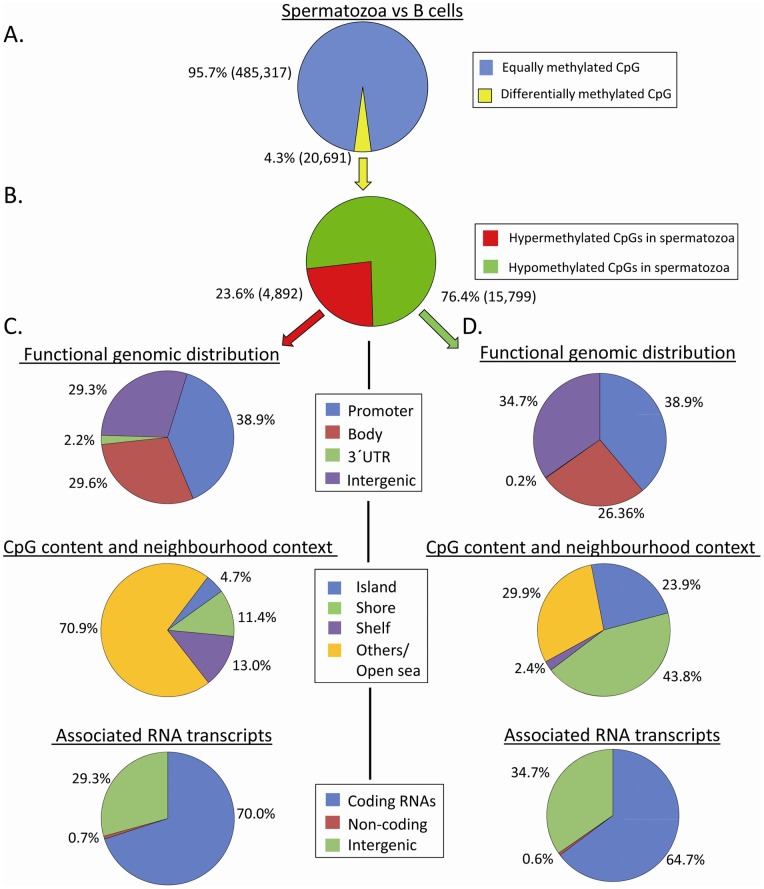
Spermatozoa versus B cell: a 450K DNA methylation
portrait.(A) Graph showing percentages of equally and differentially
methylated CpG sites in swim-up sperm samples compared to B cells.
(B) Graph showing percentages of hypermethylation and
hypomethylation in spermatozoa relating to the differentially
methylated CpGs proportion (4,3%). Graphs describing the
hypermethylated (C) and hypomethylated (D) sites according to their
i) functional genomic distribution; ii) CpG content/neighborhood
context and iii) association with RNA transcripts.